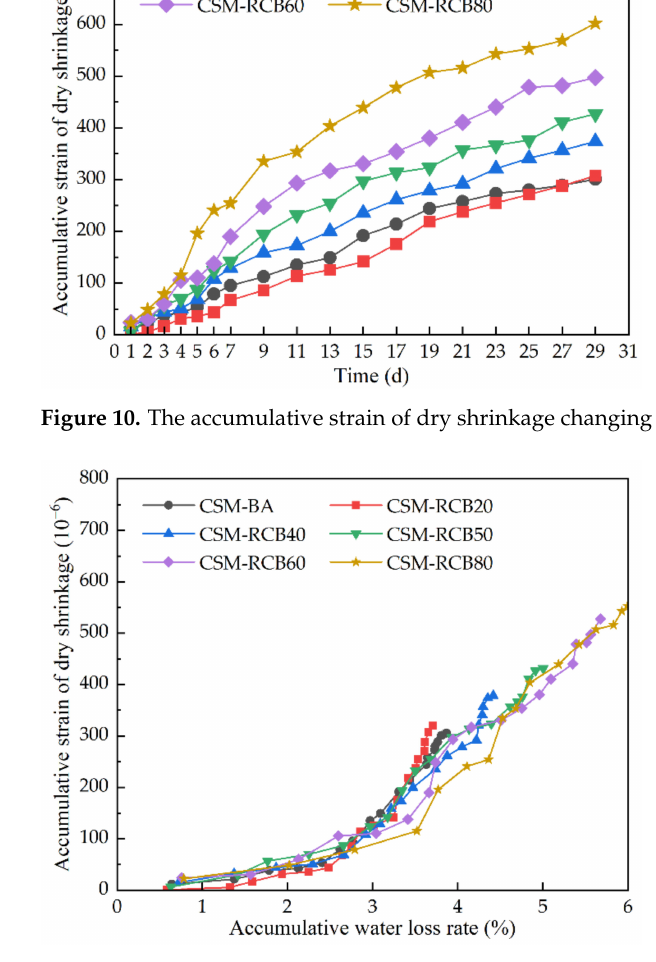
Figure 11. The accumulative strain of dry shrinkage changing with accumulative water loss